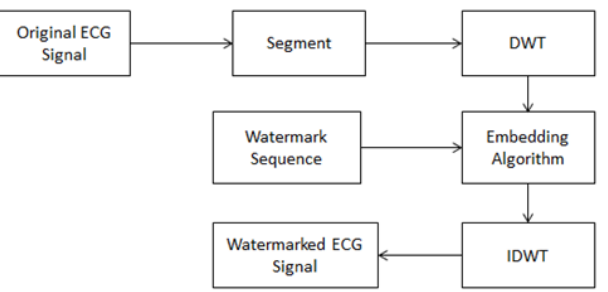
Figure 3. Watermark embedding